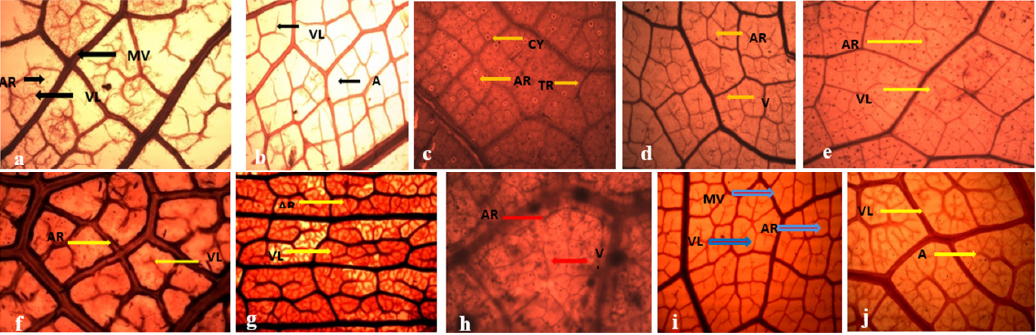
Figure 1. The venation patterns of the species studied a) F. leprieurii ; b) F. thonningii ; c) F. mucuso ; d) F. lutea e) F. polita ; f) F. sur ; g) F. benjamina ; h) F. exasparata; i) F. recurvata ; j) F. elastica Legend: MV= Main Vein, VL=Veinlet, AR= Areole, CY=Cystolith, TR = Trichome Table 2. Quantitative parameter of the venation pattern of ten Ficus species studied Plant species Areole width (µm) Areole length (µm) Number of veinlets ending Ficus lutea 92.27±7.54 ab 120.00±4.84 a 0 - 3 F. thonningii 88.00±3.22 b 116.80±5.61 a 0 - 3 F. exasperata 87.47±3.84 b 120.00±3.84 a 0 - 3 F. mucuso 84.27±4.05 b 116.27±5.16 a - F.recurvata 54.40±4.15 c 70.40±4.38 b 0 - 3 F. leprieurii 107.00± 4.70 a 132.80±4.83 a 0 - 6 F. polita 96.53±3.84 a 130.67±3.88 ab 0 - 1 F. sur 68.53±3.29 c 82.67±5.20 b 0 - 2 F. elastica 103.2±9.54 a 131.47±8.76 a 0 - 3 F. benjamina 55.73±3.47 b 80.8±2.80 c 0 - 3 *Means with the same letter along columns are not significantly different at P ≤